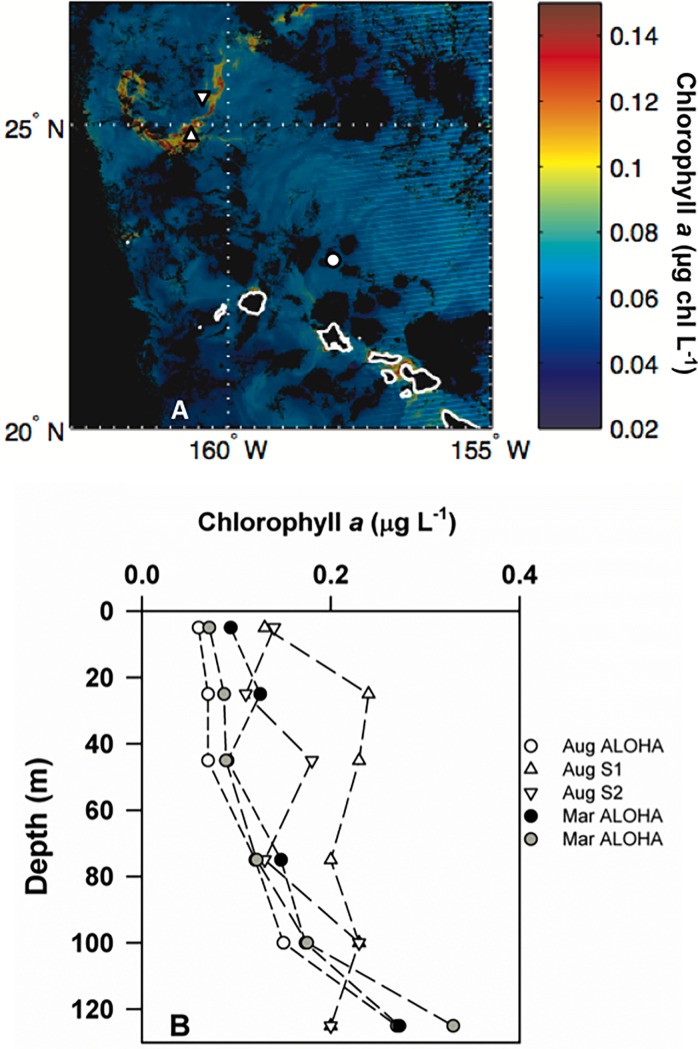
Chlorophyll concentrations and station locations.Satellite ocean color image depicting distributions and concentrations of near-surface ocean chlorophyll a (μg/ L-1) in the proximity of the Hawaiian Islands on August 21, 2010 (panel A). This image was derived from MODIS Aqua data using the color index (CI) algorithm [38] with no flags applied. The locations of the three stations occupied in August 2010 are also indicated; Station ALOHA is depicted as a circle, while stations S1 and S2 are depicted by triangles. Depth profiles of chlorophyll a during the depth-dependent experiments are also shown (panel B).